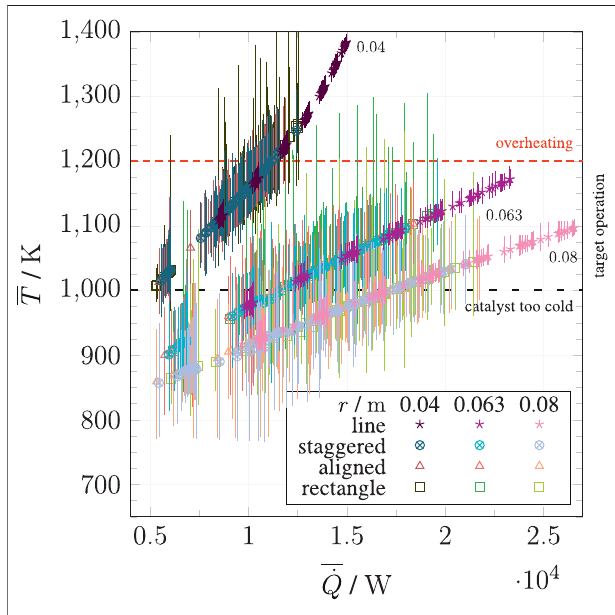
FIGURE 12 | Mean wall temperature T vs. mean heat fl ux _ Q . Minimum and maximum temperatures of each simulation are included as pseudo-error bars. Upper operation limit of tubes (red dotted line) and lower operation limit (black dotted line) are included. Symbols (and associated color family) indicate the geometrical con fi guration corresponding to the data point. Shades of the respective color indicate the inner tube radius r .